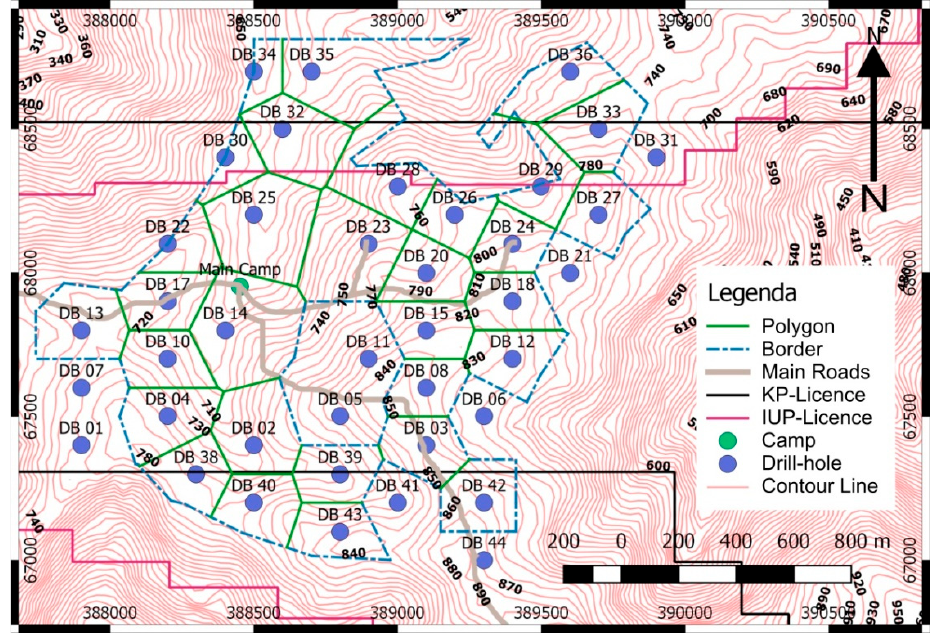
Figure 10. Boundary of the deposit using the cut-off criterion ≥ 0.7%. Value of deposit parameters for individual drill holes are presented in Table A2. The results of the calculations (Ni and Co) with a breakdown into individual horizons for filed and different cut-off criteria are shown in the Table 8.